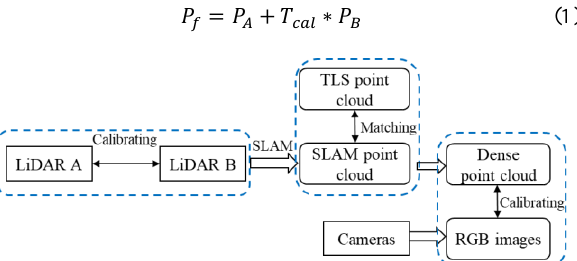
Figure 8. Flowchart of the calibration process (Wen et al.,